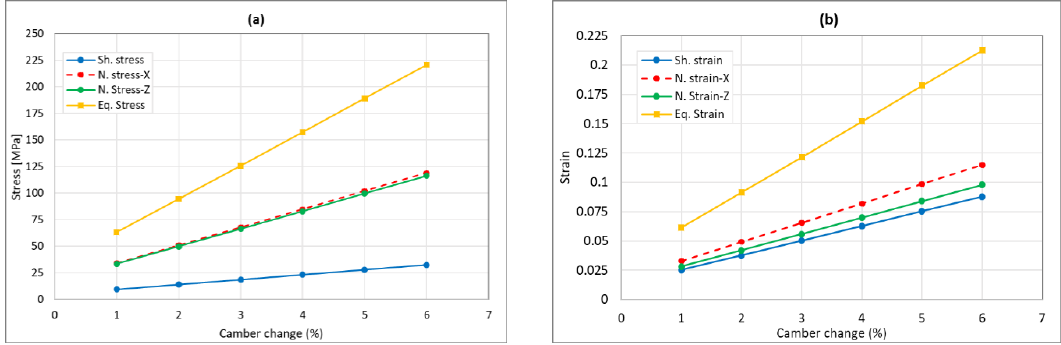
Figure 10. The 2D-plate model; ( a ) camber rate vs. stress and ( b ) camber rate vs. strain.